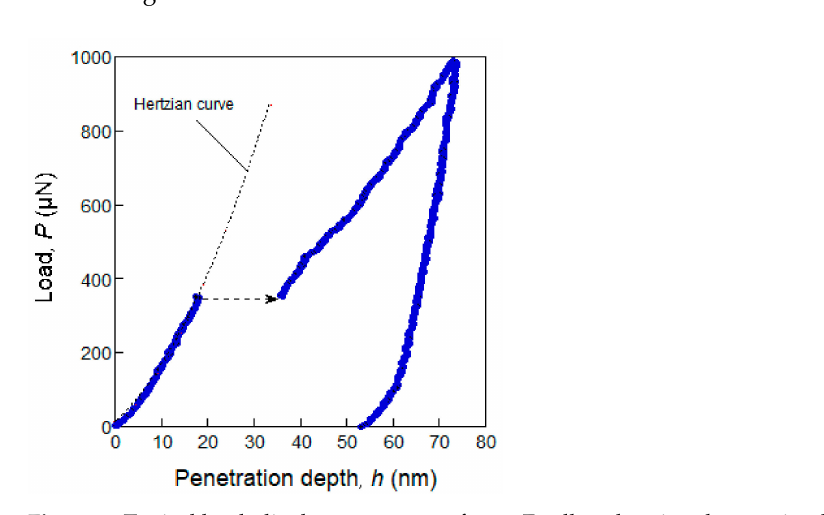
Figure 1. Typical load–displacement curve for an Fe alloy showing the pop-in phenomenon on the loading curve, indicated by the dashed-line arrow. The broken line represents a Hertzian curve fitted with the experimental